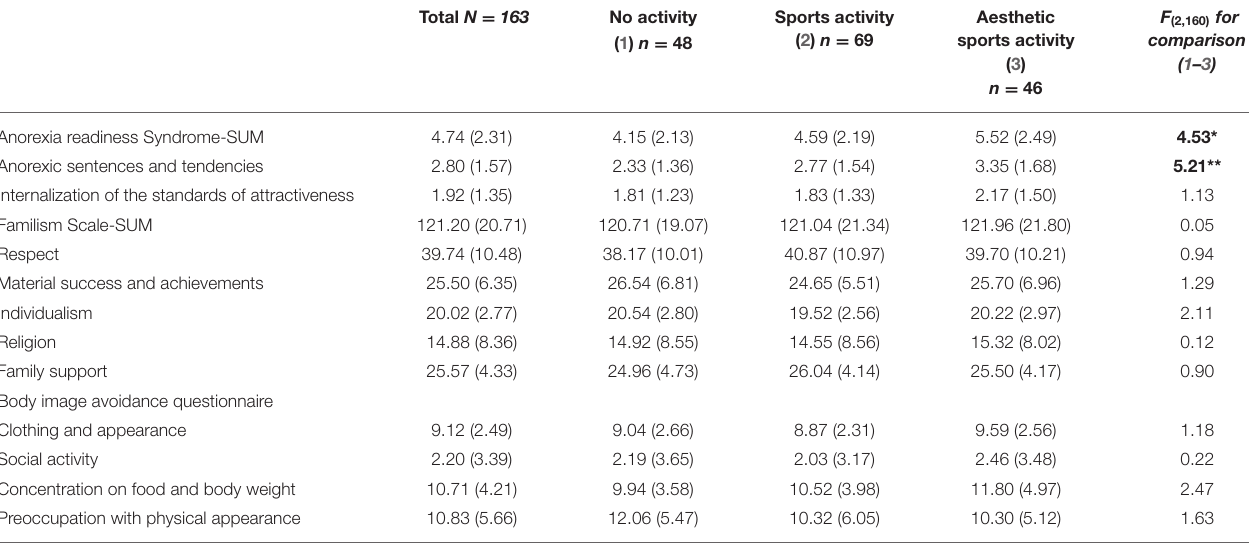
TABLE 2 | Differences between the compared groups with regards to: Anorexia Readiness Syndrome–ARS, familism and body